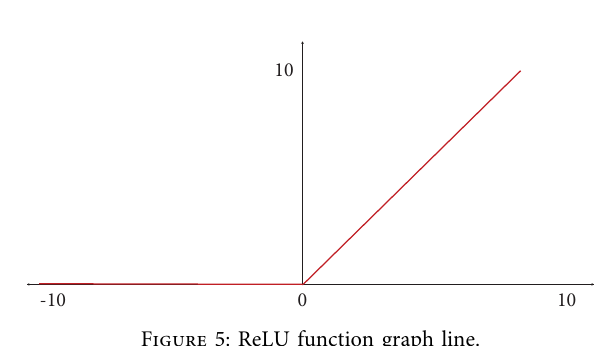
Figure 5: ReLU function graph line.